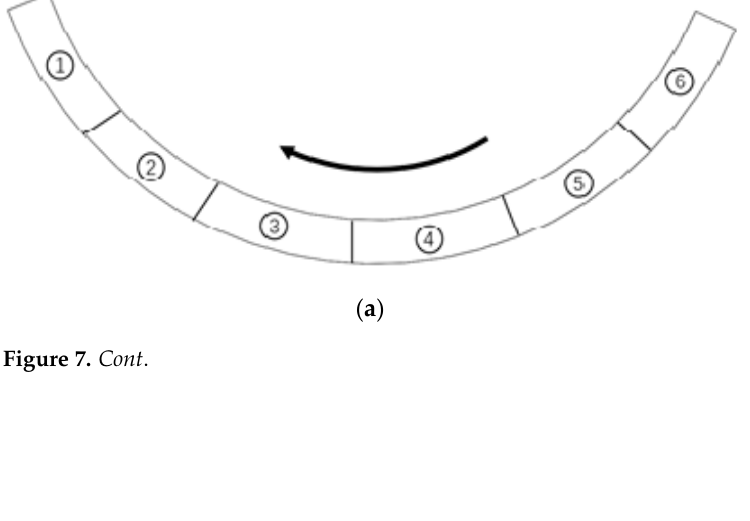
Figure 6. Schematic diagram of node selection location. Table 3. Residual stress and deformation of base